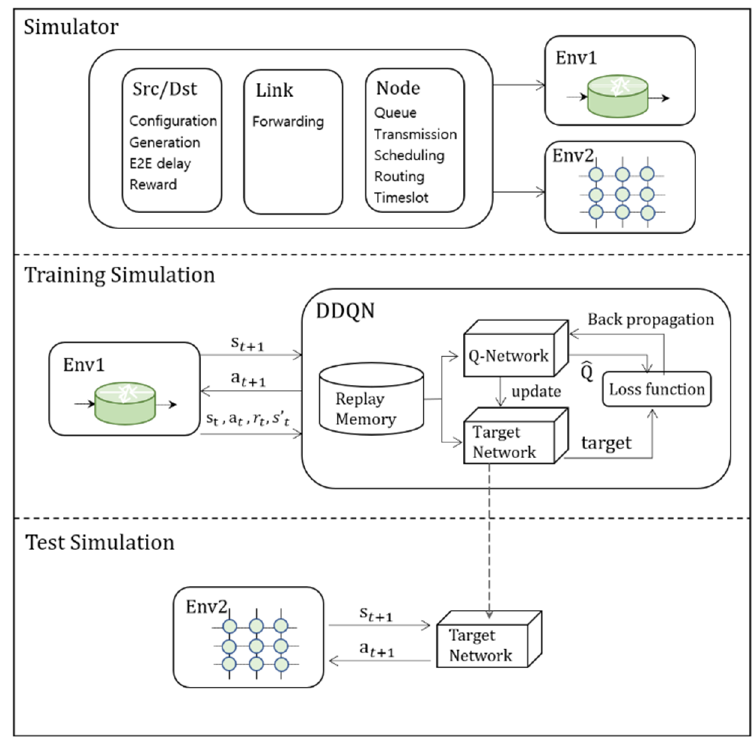
Figure 2. Workflow of the proposed approach.